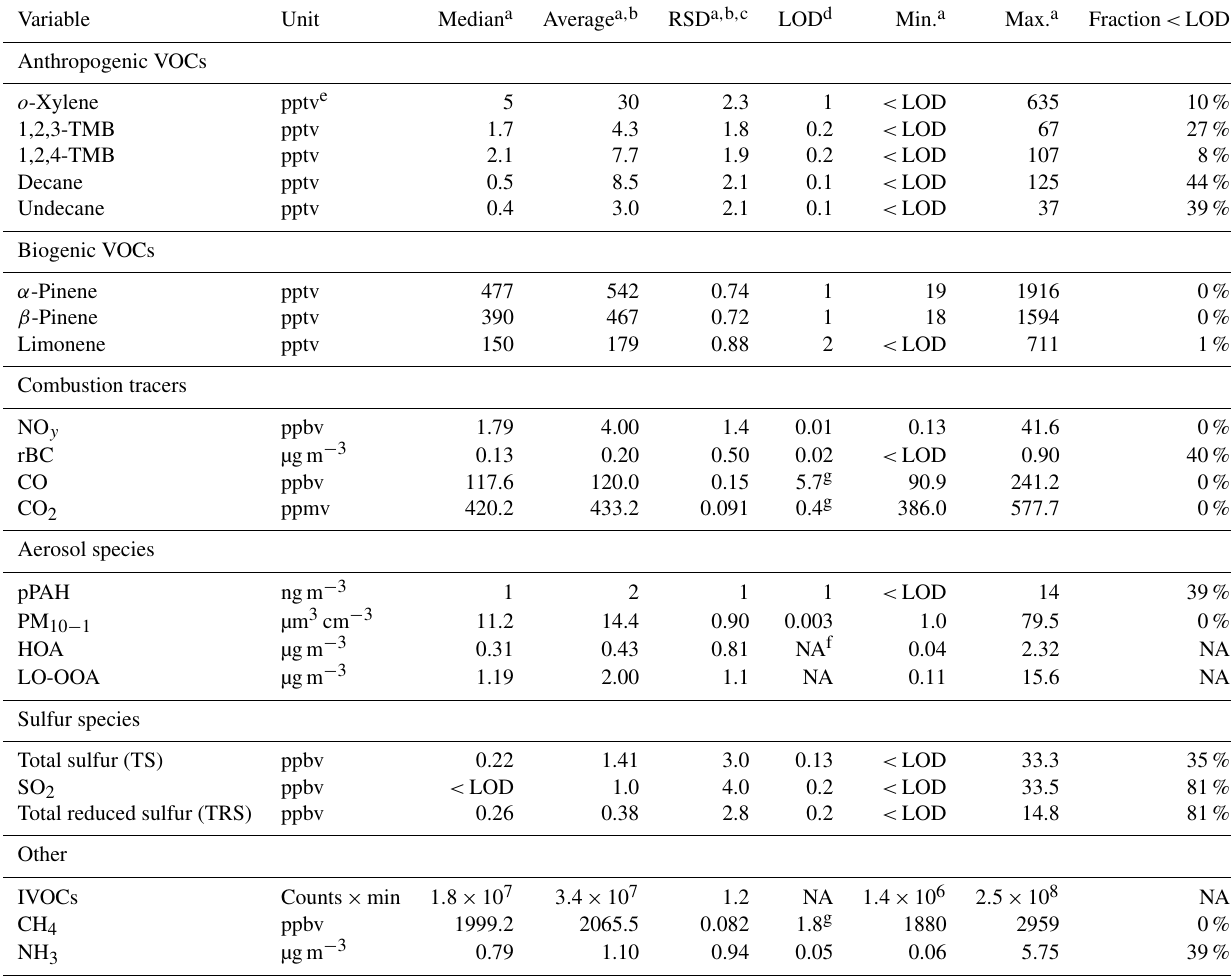
a Values were determined only from data points included in the PCA, not from the entire campaign. b Average and relative standard deviation were calculated before zeros were replaced with 0.5 × LOD. c RSD: relative standard deviation. d LOD: limit of detection. e ppt: parts per trillion by volume (10 − 12 ). f NA: data not available. g Calculated using 3 × standard deviation at ambient background